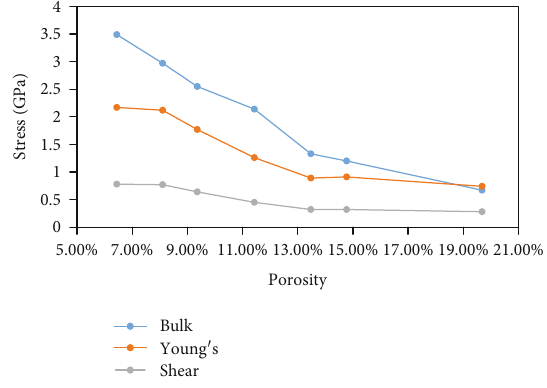
Figure 9: Elastic moduli as a function of porosity for kerogen containing eight units.